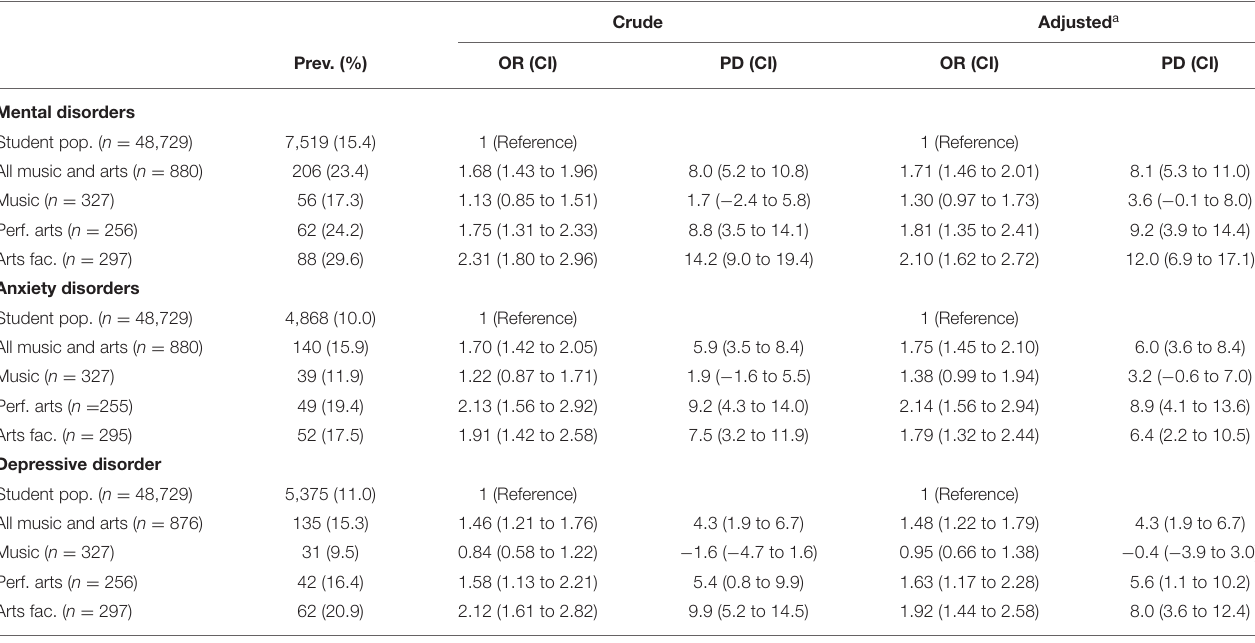
TABLE 3 | Logistic regression analysis of prevalence of symptoms of self-reported overall mental, anxiety, and depressive disorders in Norwegian music and arts students compared to the general student population. Crude Adjusted a